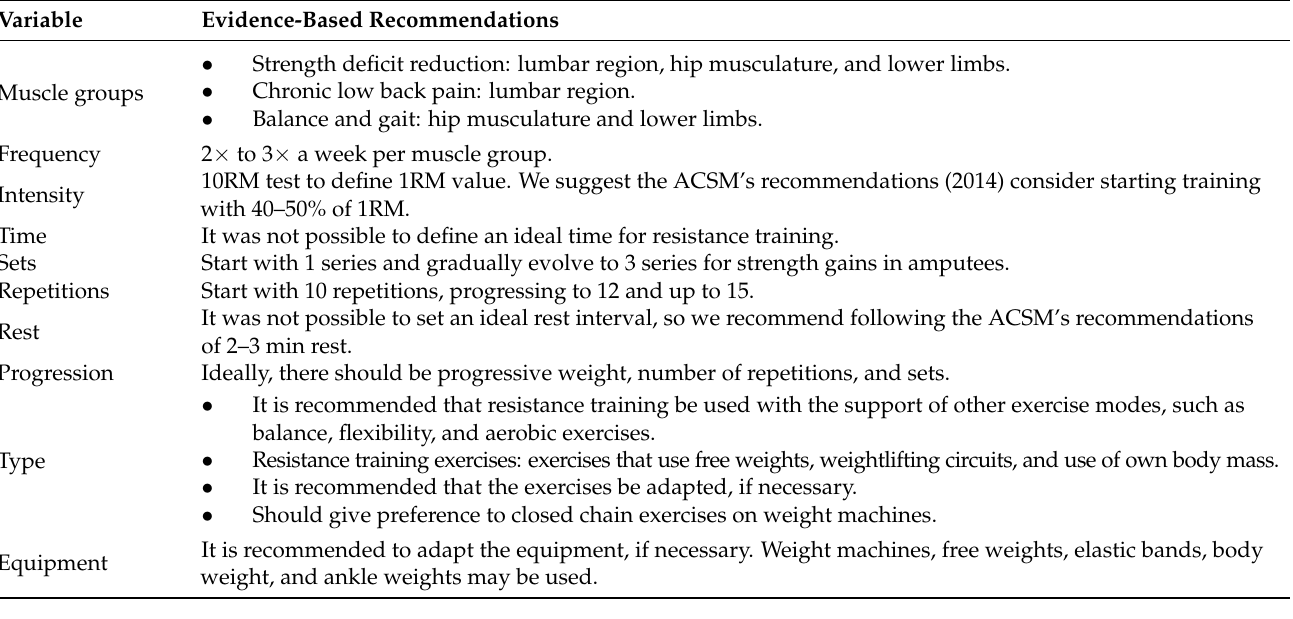
Table 6. Resistance training practical recommendations for